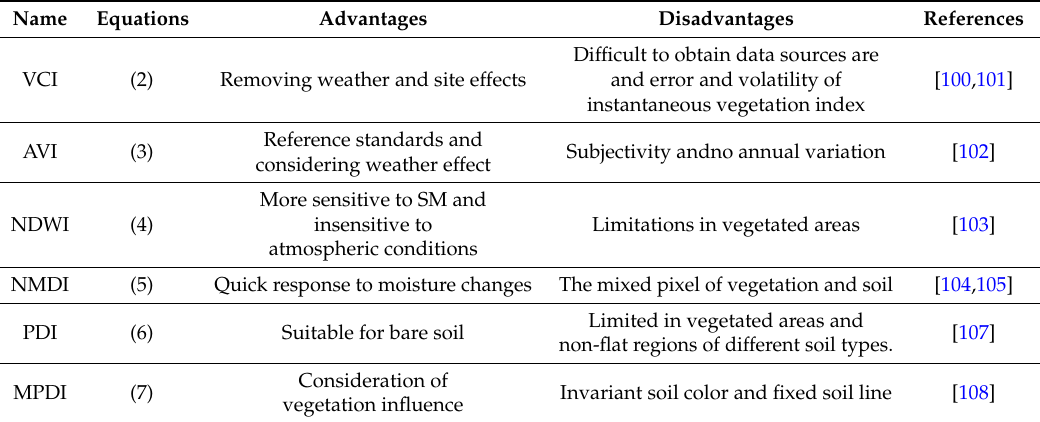
Table 2. Comparison of several common drought